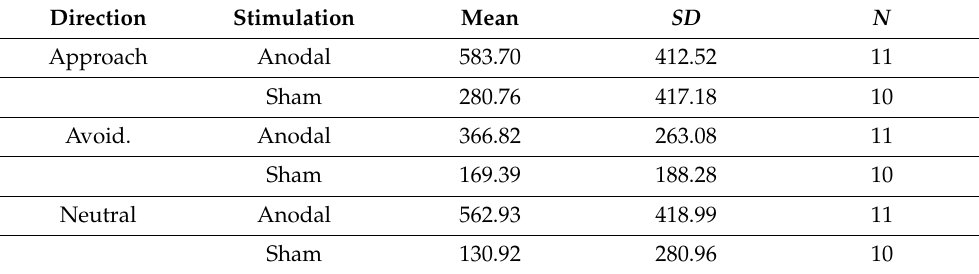
Table 5. Descriptive statistics of d for low-BIS participants in each